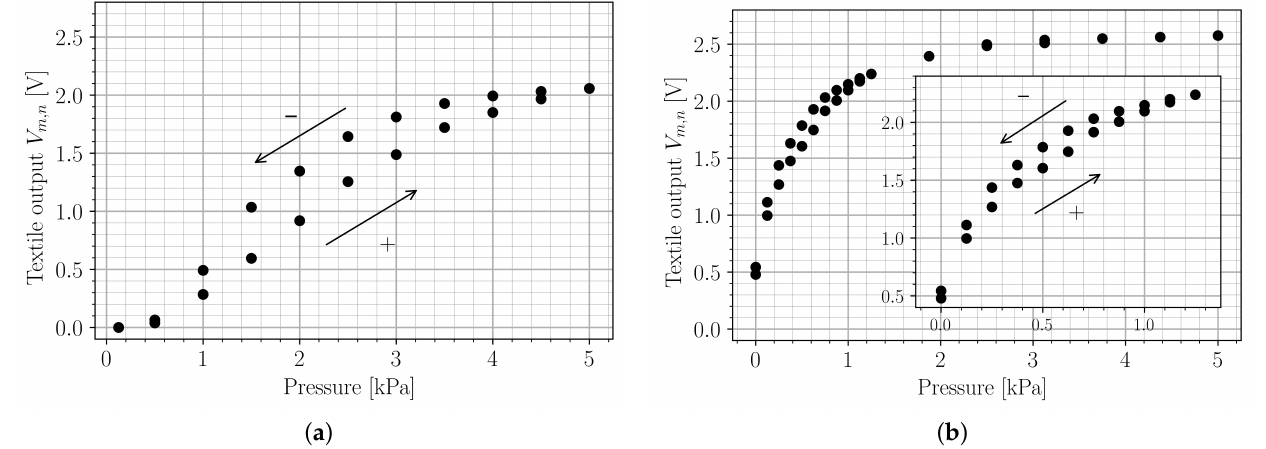
Figure 5. Pressure characteristics of a single smart textile matrix point for different values of the pull- down resistor R A of the analog PCB pins. “ + ” denotes rising pressure; “ − ” indicates diminishing pressure. ( a ) R A = 1.5k Ω ; ( b ) R A = 3.9k Ω